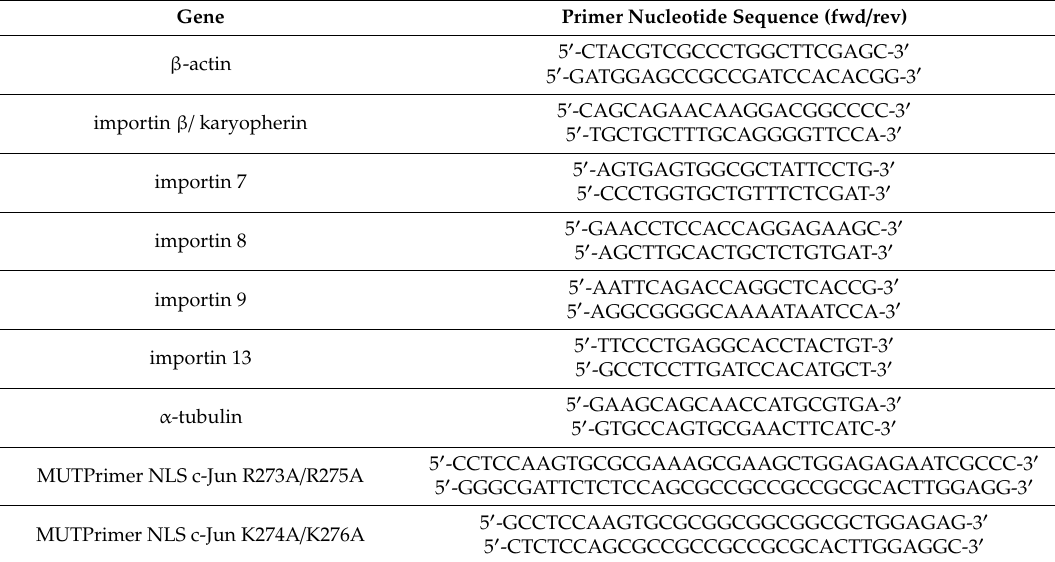
Table 1. Primers for mRNA quantification by qRT-PCR and mutation